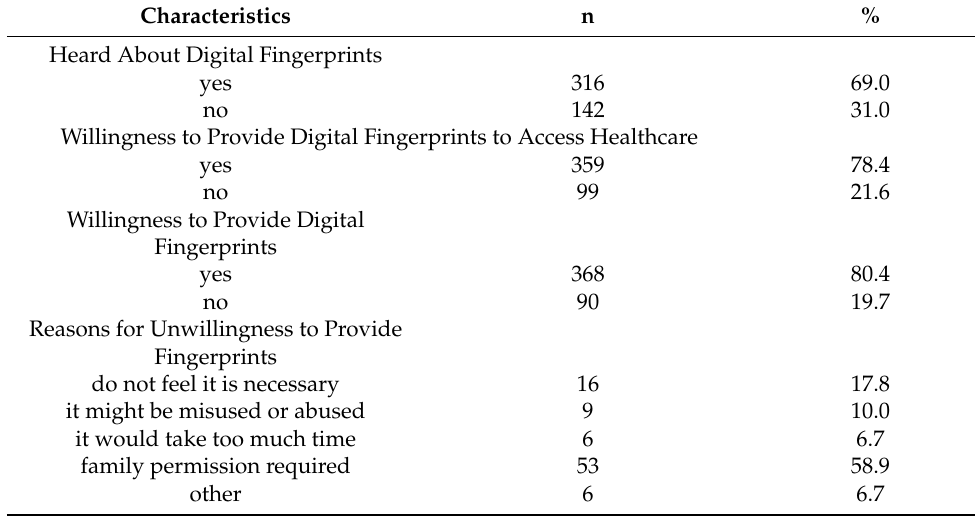
Table 2. Willingness to provide digital fingerprints to access healthcare services (N = 458).